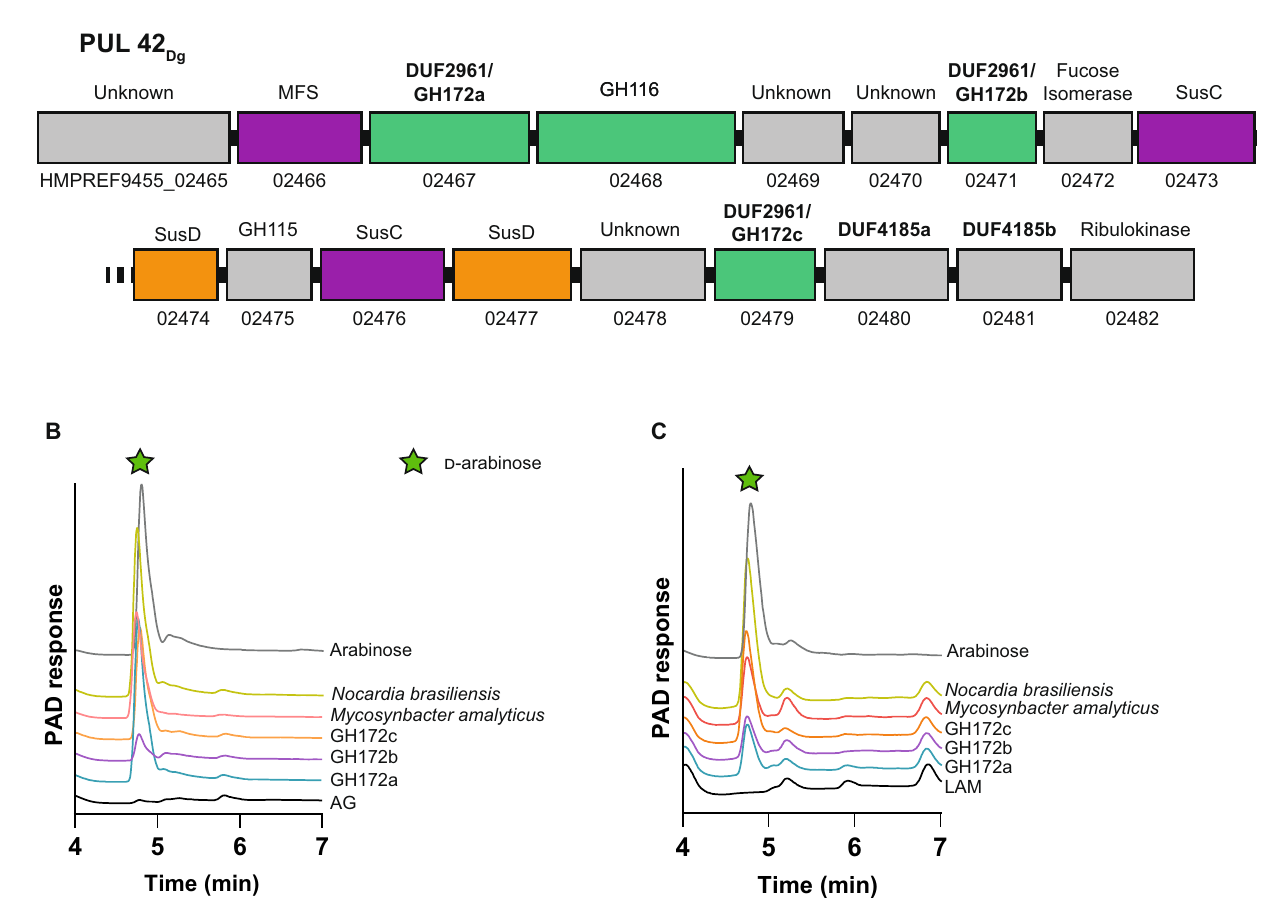
Fig.2| D.gadei DUF2961genesencodeGH172exo- D -arabinofuranosidaseswith orthologs in diverse bacteria. A Schematic of PUL42 as identi fi ed by proteomic analysisof D.gadei grownon D -arabinan. B DUF2961enzymes(1 µ M)vs2mgml -1 AG and ( C ) LAM. Samples were analyzed by ion chromatography with pulsed